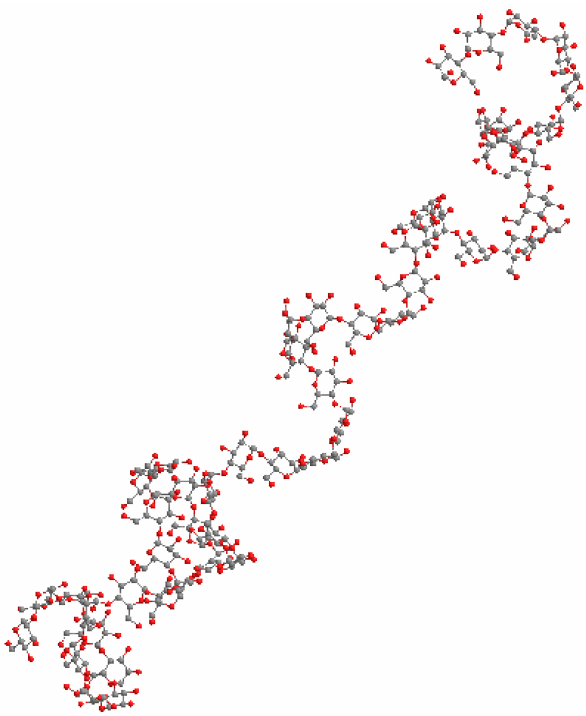
Figure 3. Molecular model of simulated amylose chains.